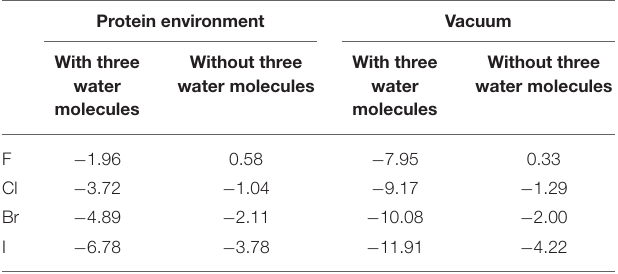
TABLE 4 | Halogen bond interaction energy 1 E (kcal/mol) of halides in the protein-rich environment and in vacuum (at the MP2/aug-cc-pVTZ-PP level of theory for I and at the MP2/aug-cc-pVTZ level of theory for H, C, N, O, F, Cl, and Br). Protein environment Vacuum With three Without three With three Without three water water molecules water water molecules molecules